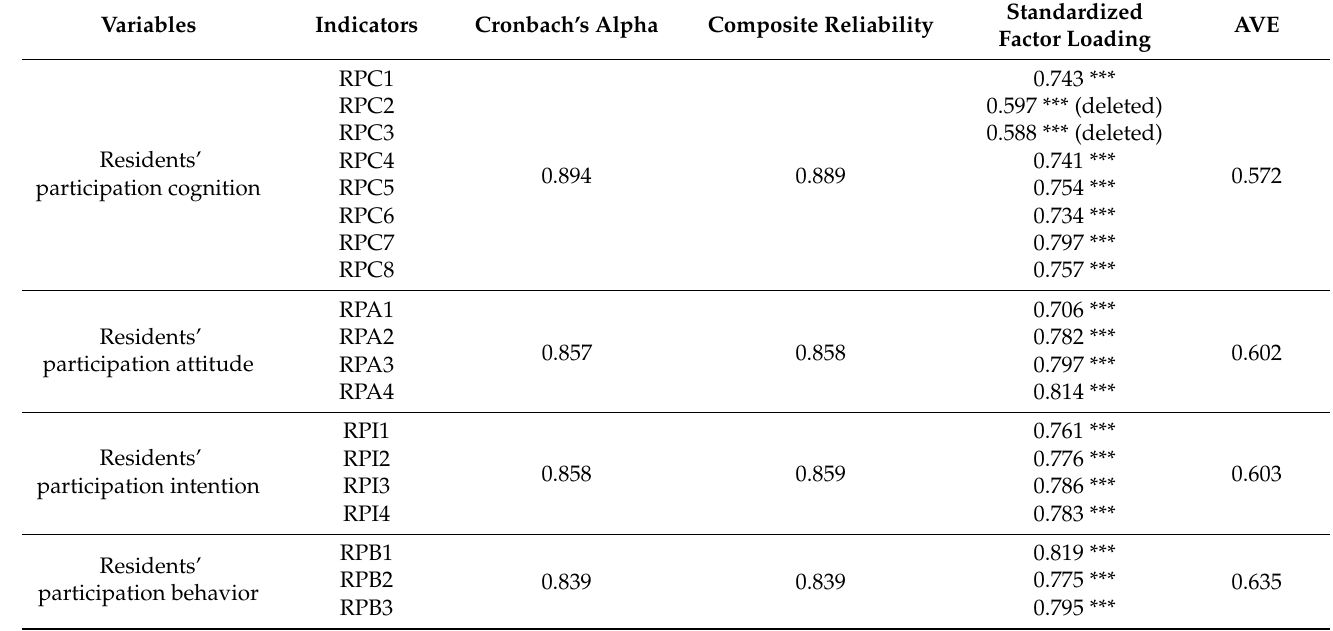
Table A3. Results of confirmatory factor analysis.